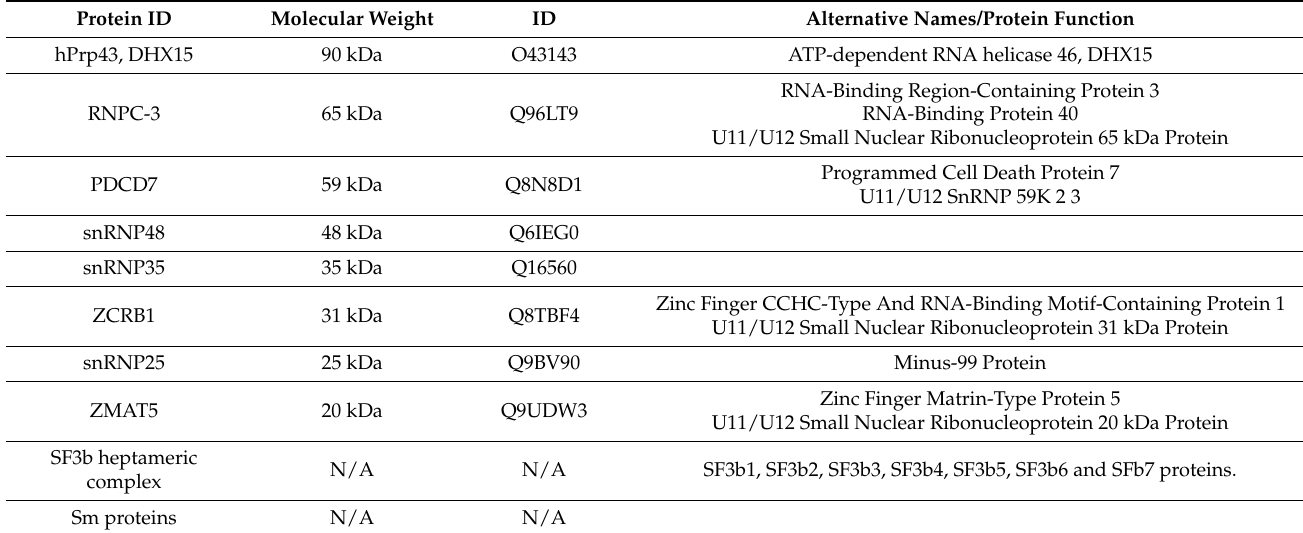
Table 3. Proteins of the U11/U12 complex [32] ordered according to the molecular